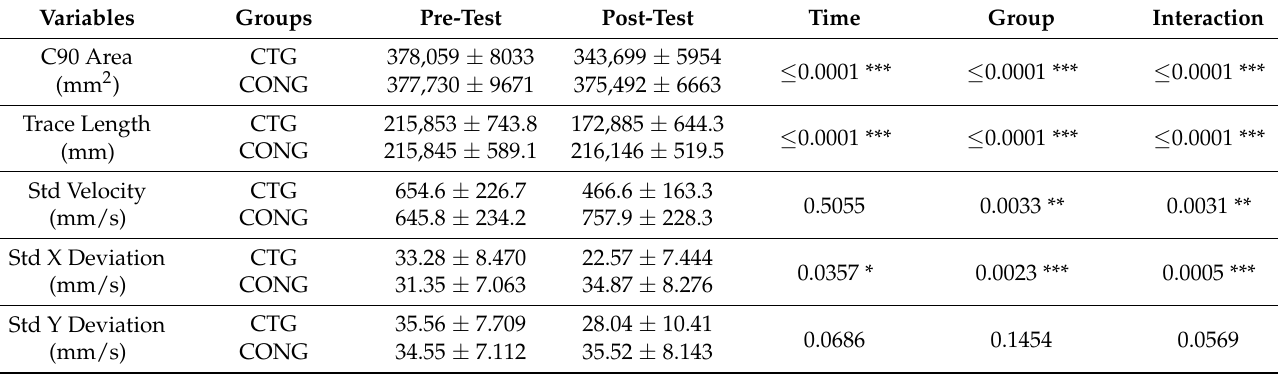
Table note: CTG (n = 20), CONG (n = 20), * means p ≤ 0.05, ** means p ≤ 0.01, *** means p ≤